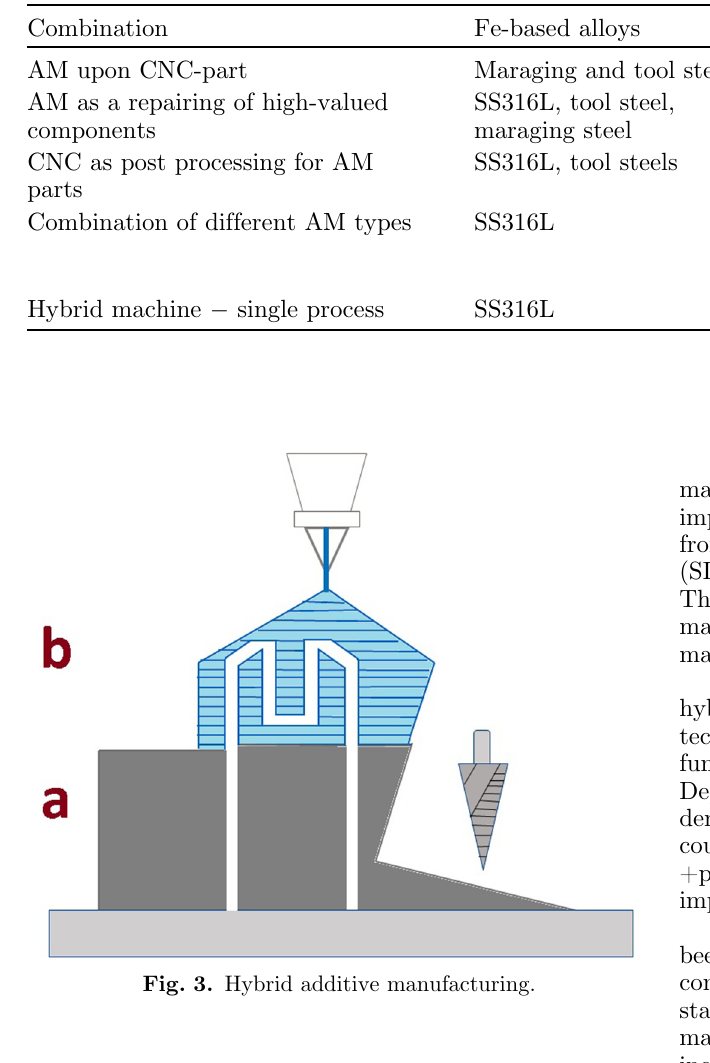
Table 3. Hybrid additive